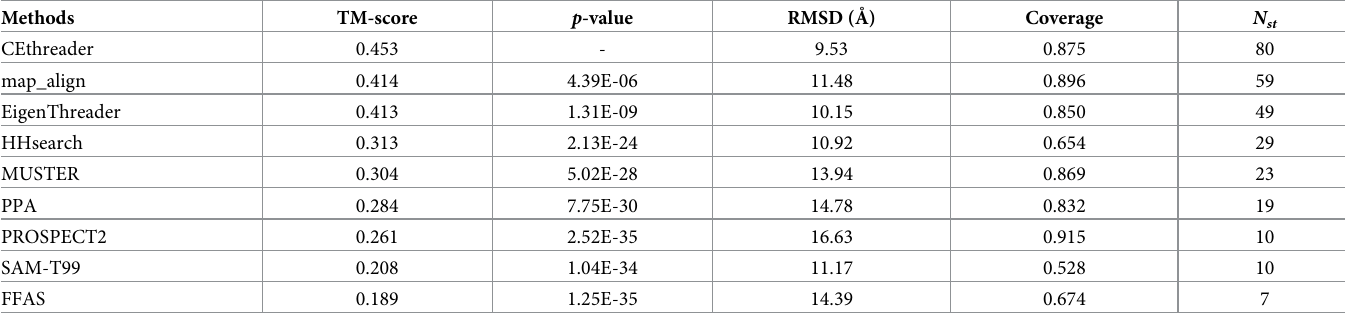
Table 1. Performance of different threading methods on the 211 Hard targets from Benchmark Set-I. P -values were calculated between the CEthreader alignment TM-scores and other methods’ TM-scores using one-sided Wilcoxon signed-rank tests. Coverage is equal to the number of aligned residues divided by the length of the query sequence. N represents the number of targets with an identified template whose TM-score was > st